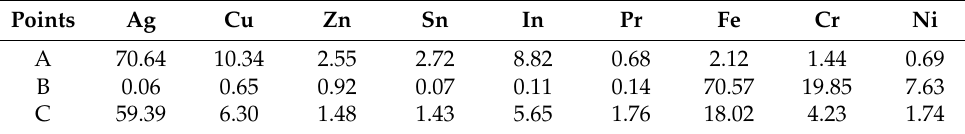
Figure 3. SEM image ( a , b ) of surface appearance after spreading of 12AgCuZnSn-2In-0.5Pr filler metal on 304 stainless steel and corresponding the elements mapping: ( c ) Ag, ( d ) Cu, ( e ) Zn, ( f ) Sn, ( g ) In, ( h ) Pr, ( i ) Fe, ( j ) Cr, ( k ) Ni. Table 2. EDS analysis results of the points indicated in Figure 3b (at.%).